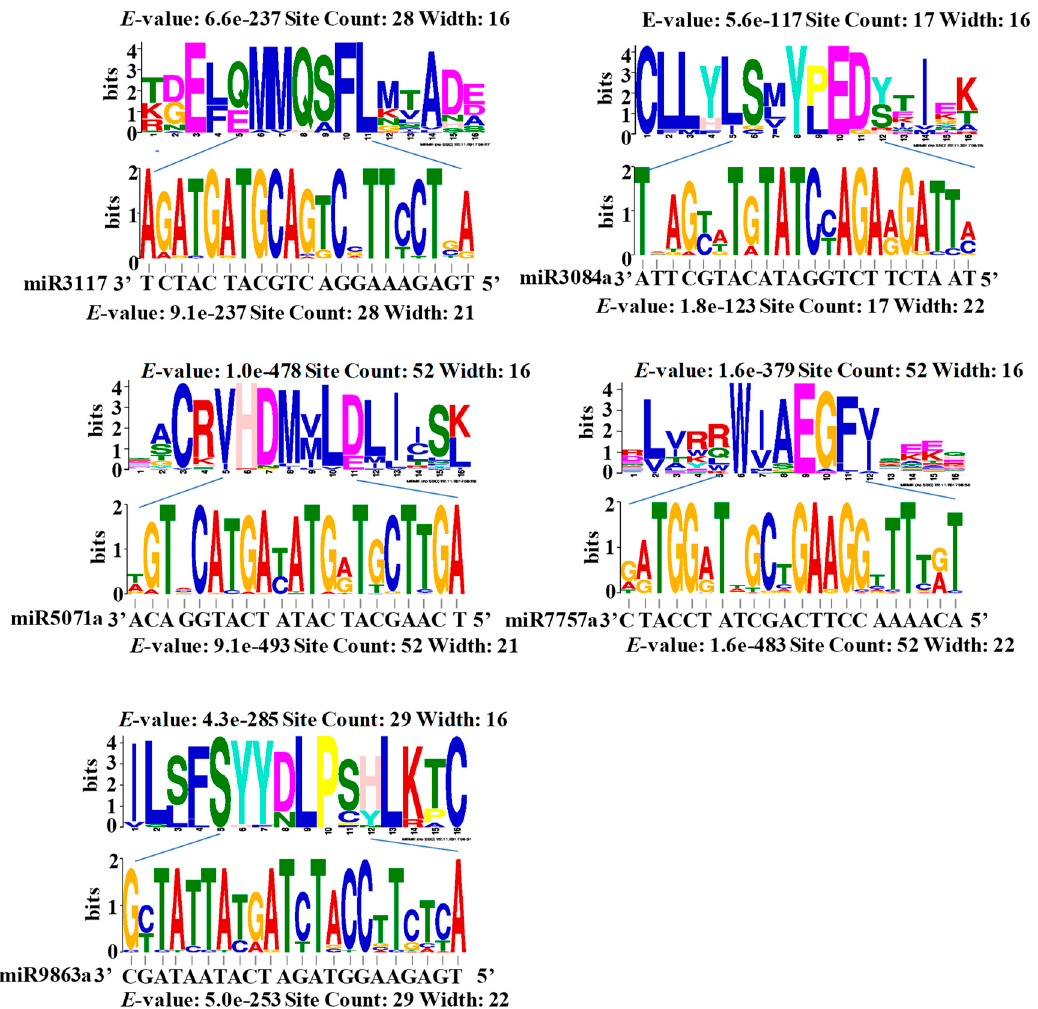
Figure 4. Motif diagram in the target sites of the disease resistance-associated miRNA: The logo diagrams show the alignment of the RNA and protein sequences in the target site and their flanking regions. The site count entries describe the number of sequences used in each alignment.